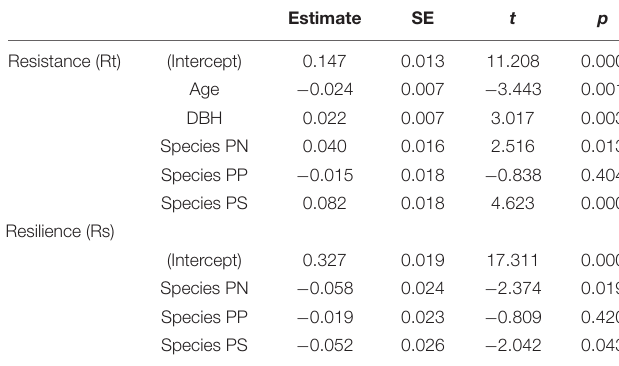
TABLE 3 | Differences in resilience during the 2005–2007 drought period between pine